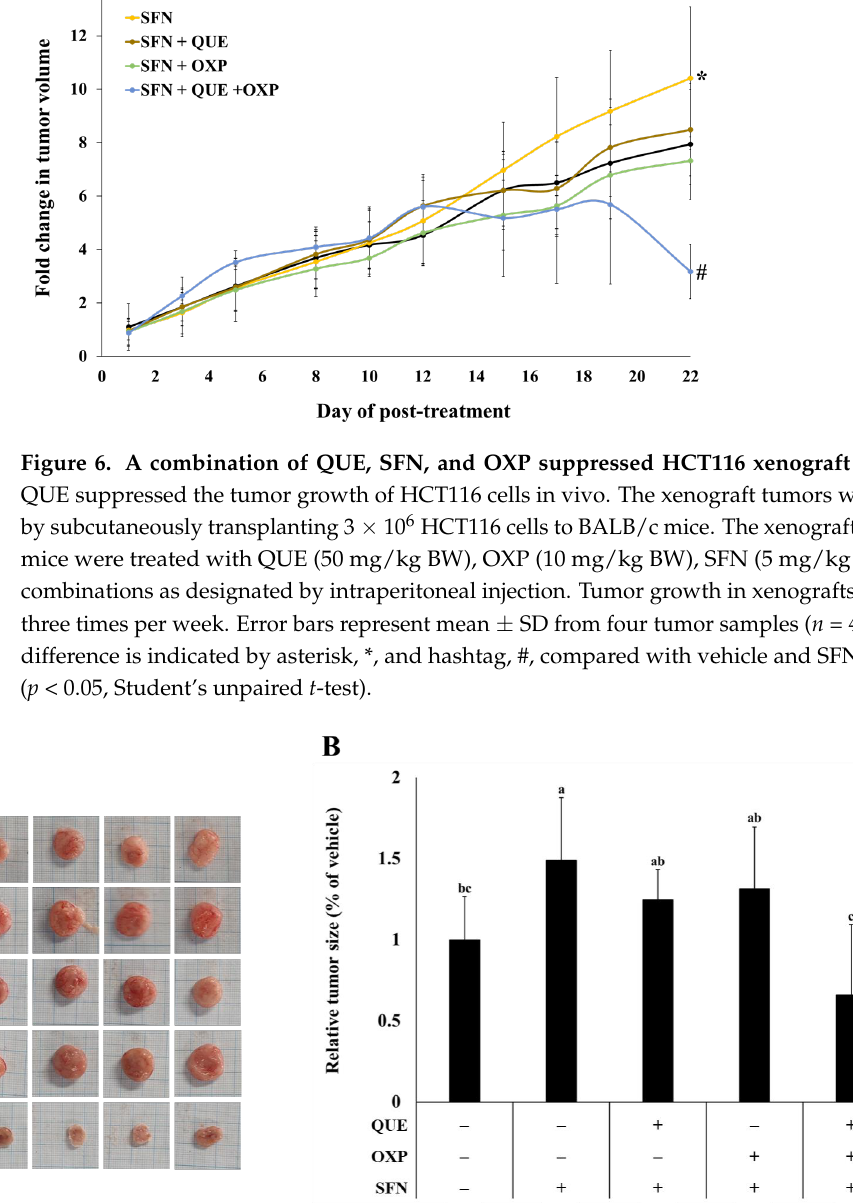
3.5. Combined Treatment of QUE and OXP Inhibited SFN-Induced HCT116 Xenograft Tumor